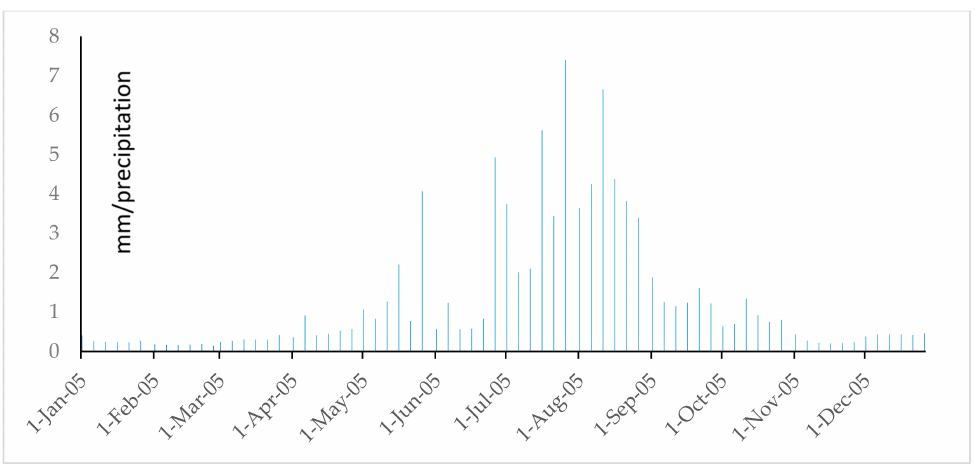
Figure A33. Precipitation of Denko County in